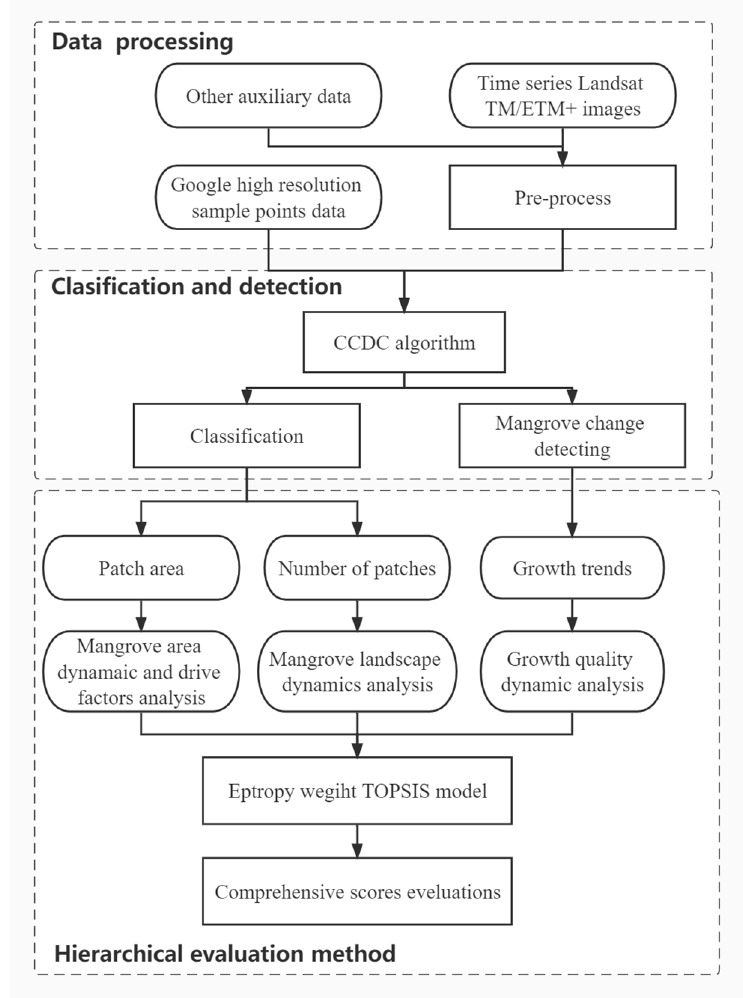
Figure 2. The flowchart of the